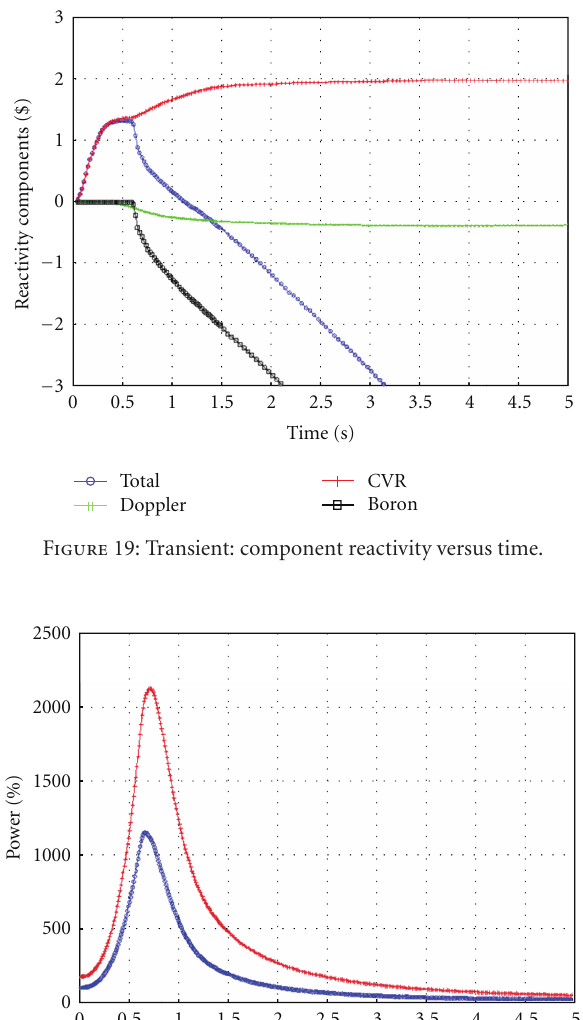
and its unique control rod configuration and